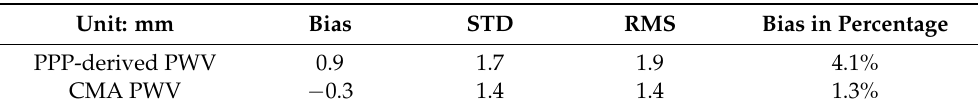
Table 1. The accuracy of GNSS PWV validated by Radiosonde. Unit: mm Bias STD RMS Bias in Percentage PPP-derived PWV 0.9 1.7 1.9 4.1% CMA PWV − 0.3 1.4 1.4